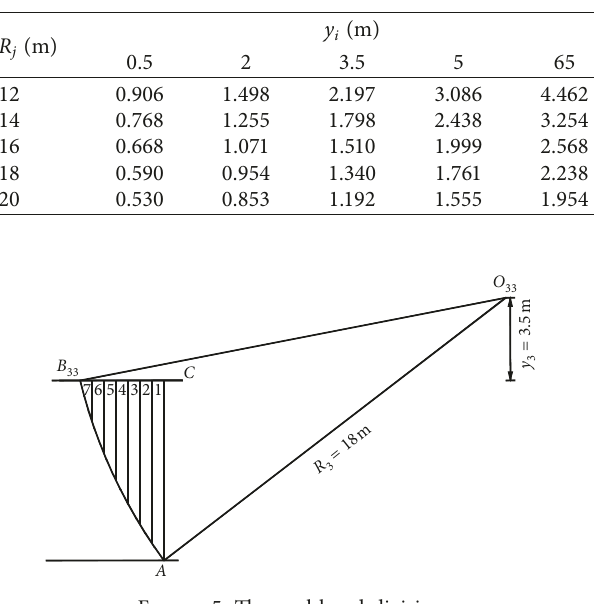
Table 1: The depth of slip